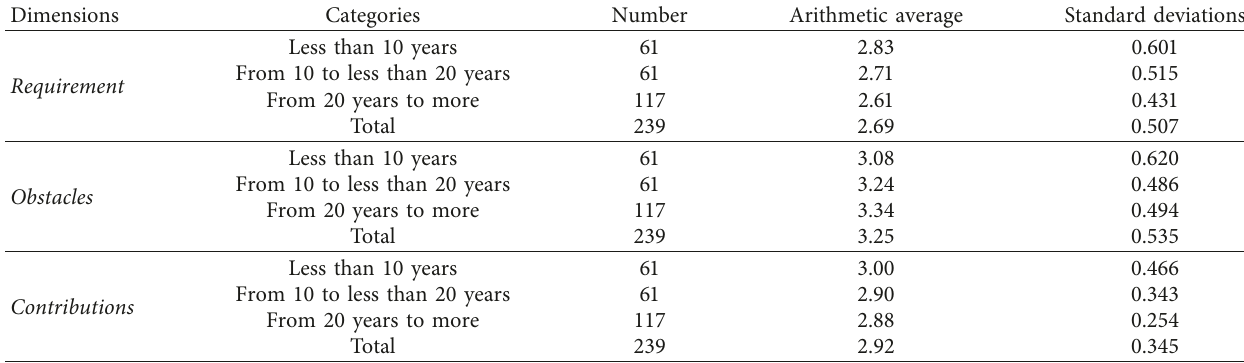
Table 13: Arithmetic averages and standard deviations of the impact of experience on requirements, obstacles, and proposed solutions to overcome distance education obstacles in the face of university educational